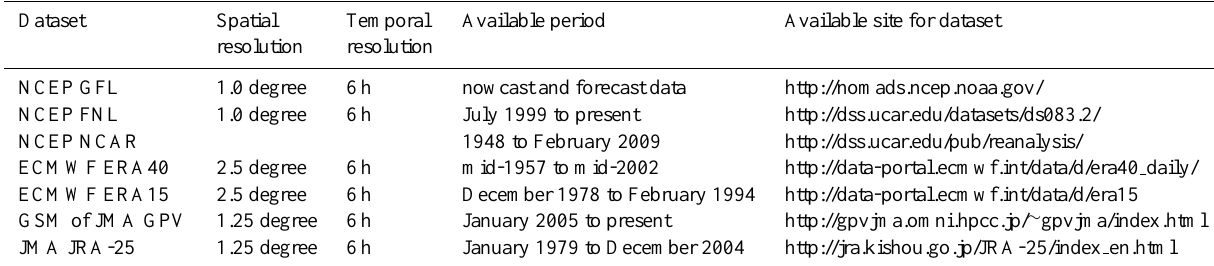
Table 2. Examples of freely available global meteorological dataset for background data of mesoscale model.